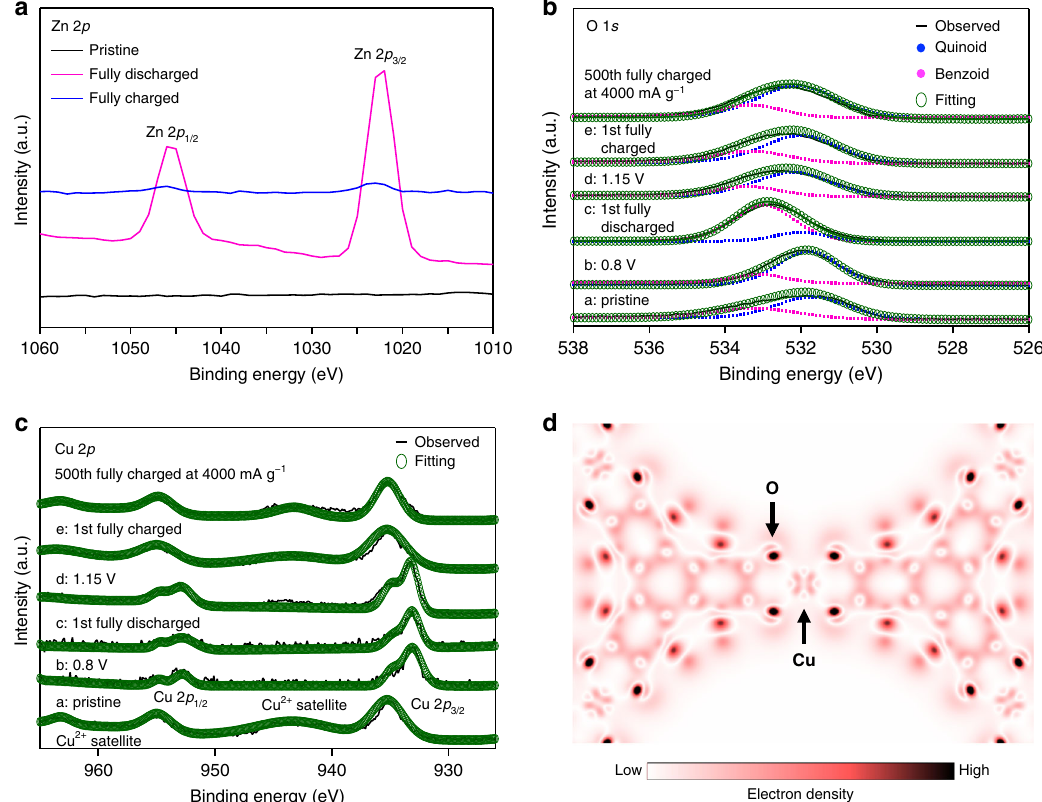
Fig. 4 Electronic states analysis during discharge – charge. a – c Ex situ XPS spectra of a Zn 2 p , b O 1 s , and c Cu 2 p . d Changes of electron density upon the reduction of Cu 3 (HHTP)